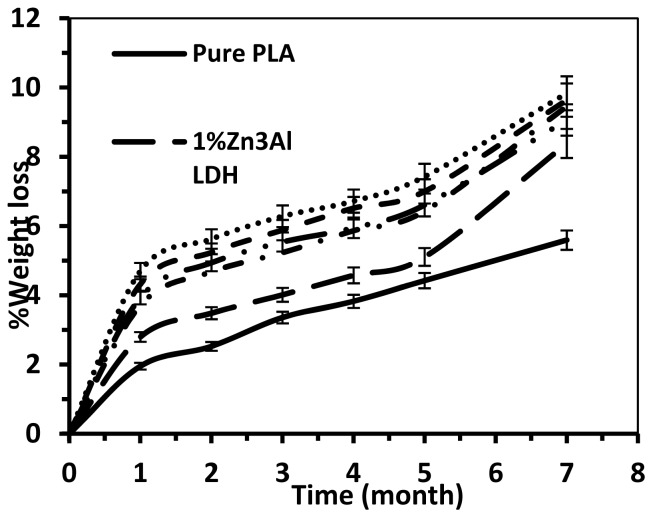
Weight losses of pure PLA and its Zn3Al LDH macrocomposites in soil for up to seven months.